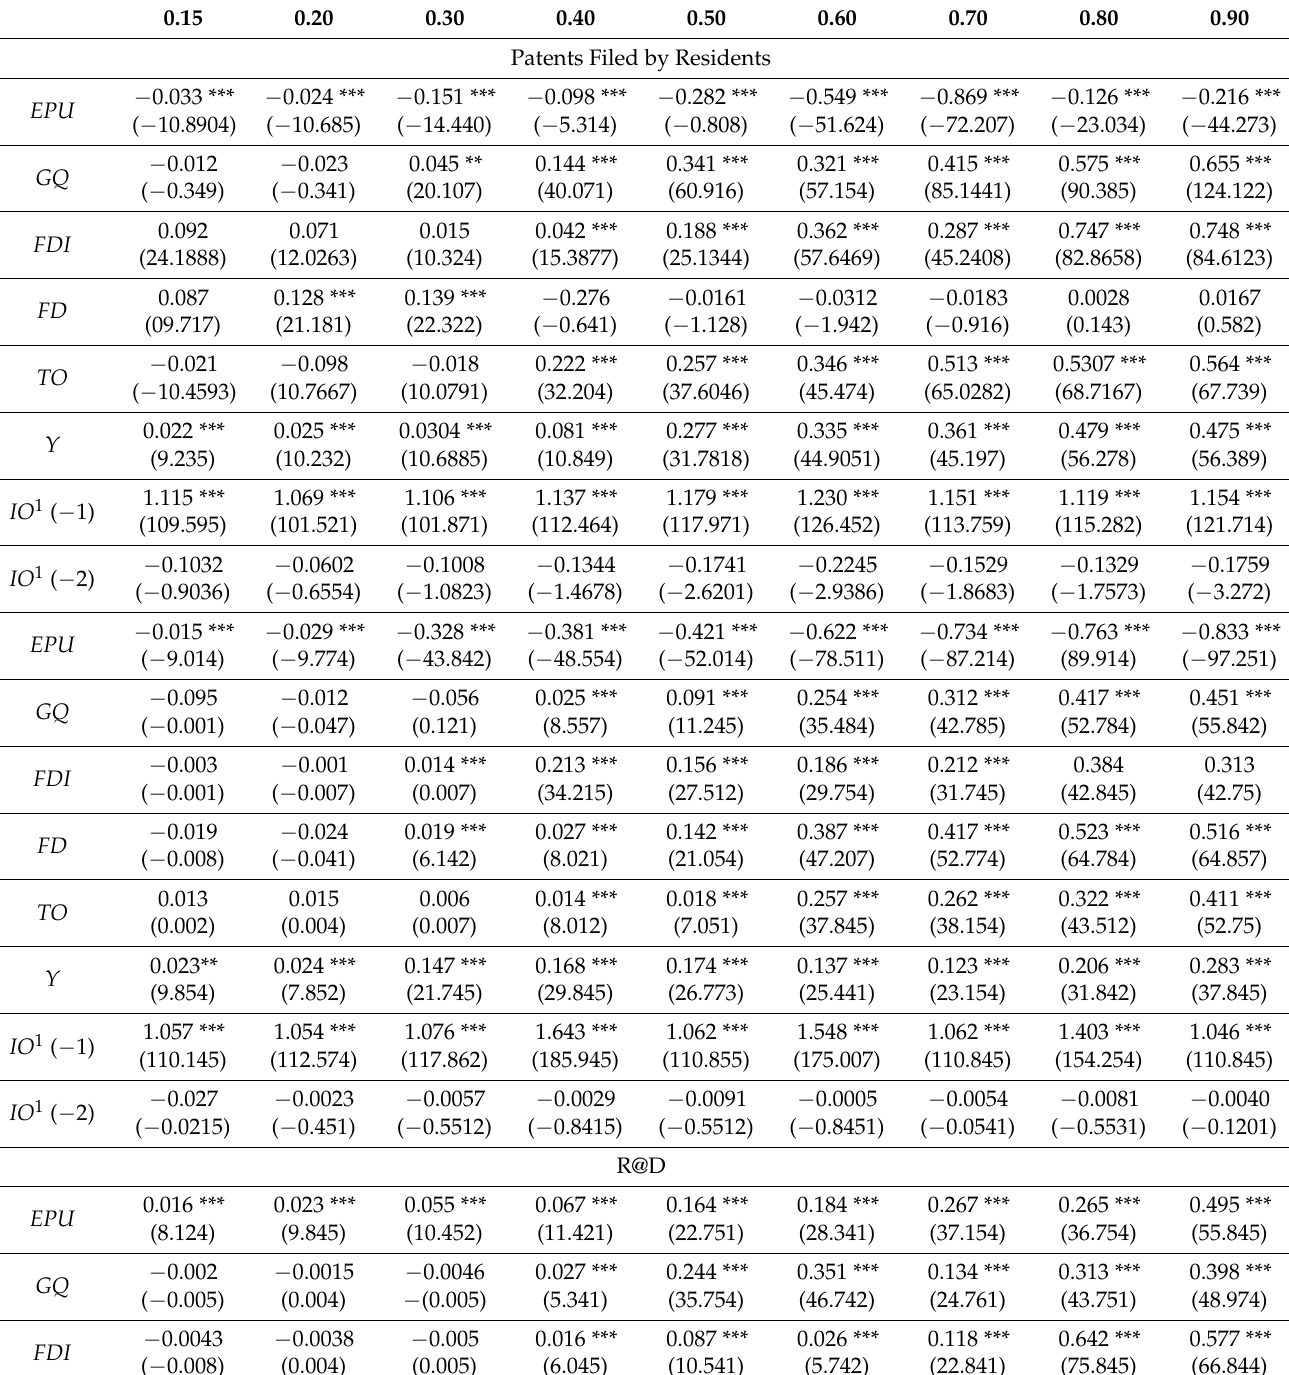
Table 12. Results of dynamic quantile regression: innovation output measured by patents filed by